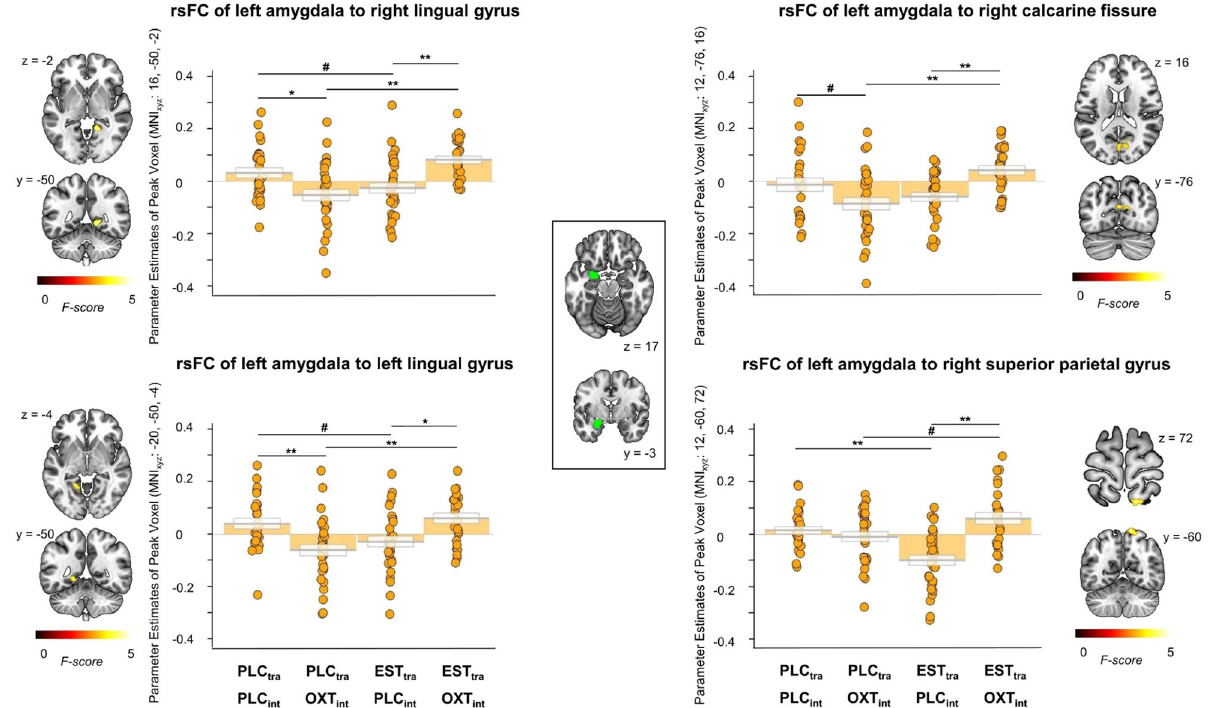
Figure 2. Treatment effects on the resting-state functional connectivity (rsFC) between the left amygdala as seed region (green cluster) and the right and left lingual gyrus, the right calcarine fissure, and the right superior parietal gyrus in men . The single treatment with either estradiol or oxytocin significantly decreased rsFC, while the combined treatment led to an rsFC comparable to that of the placebo group. Error bars indicate standard errors of the mean. PLC tra = transdermal placebo gel; PLC int = intranasal placebo; OXT int = intranasal oxytocin; EST tra = transdermal estradiol. # p < 0.1, * p < 0.05, ** p <